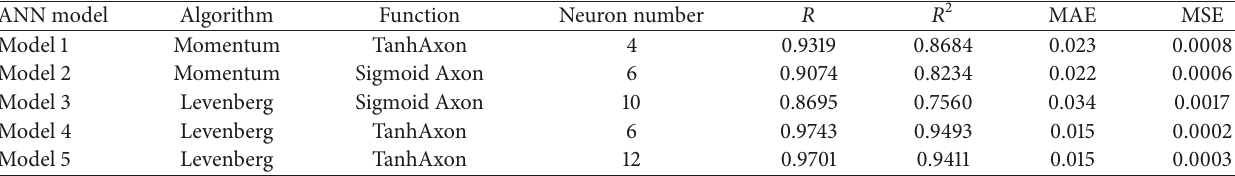
Figure 3: Neural network structures to predict of the surface Ra ( 𝜇 m). Table 2: Comparison of the developed different ANN structures for surface Ra ( 𝜇